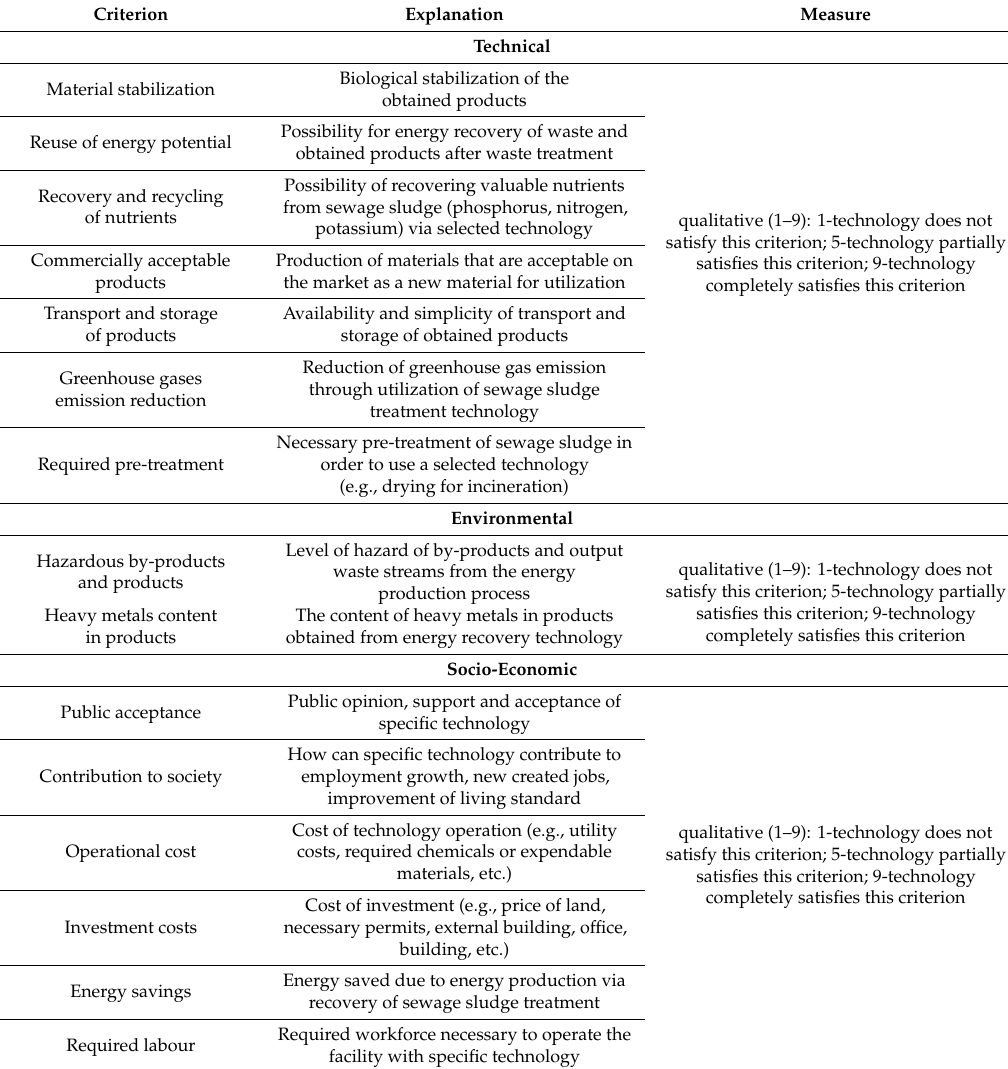
Table 4. Layout of criteria and sub-criteria used in this paper for Rijeka and applicable for